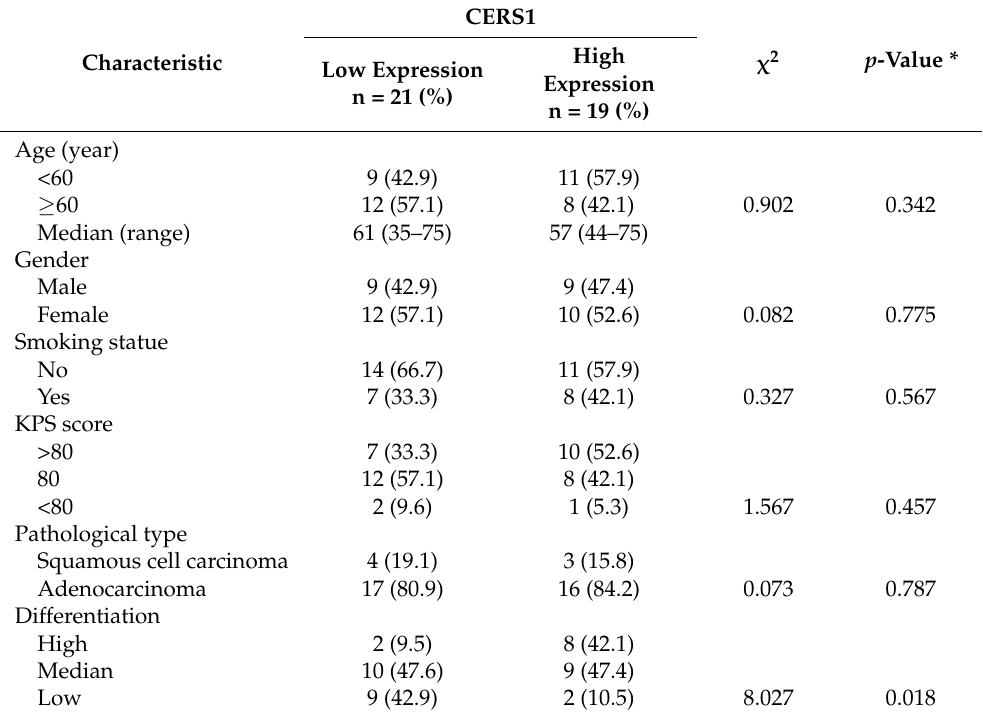
Table 1. Correlation between the expression level of the CERS1 protein and clinical data of patients with